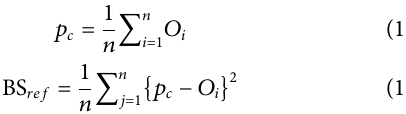
Frontiers in Earth Science |